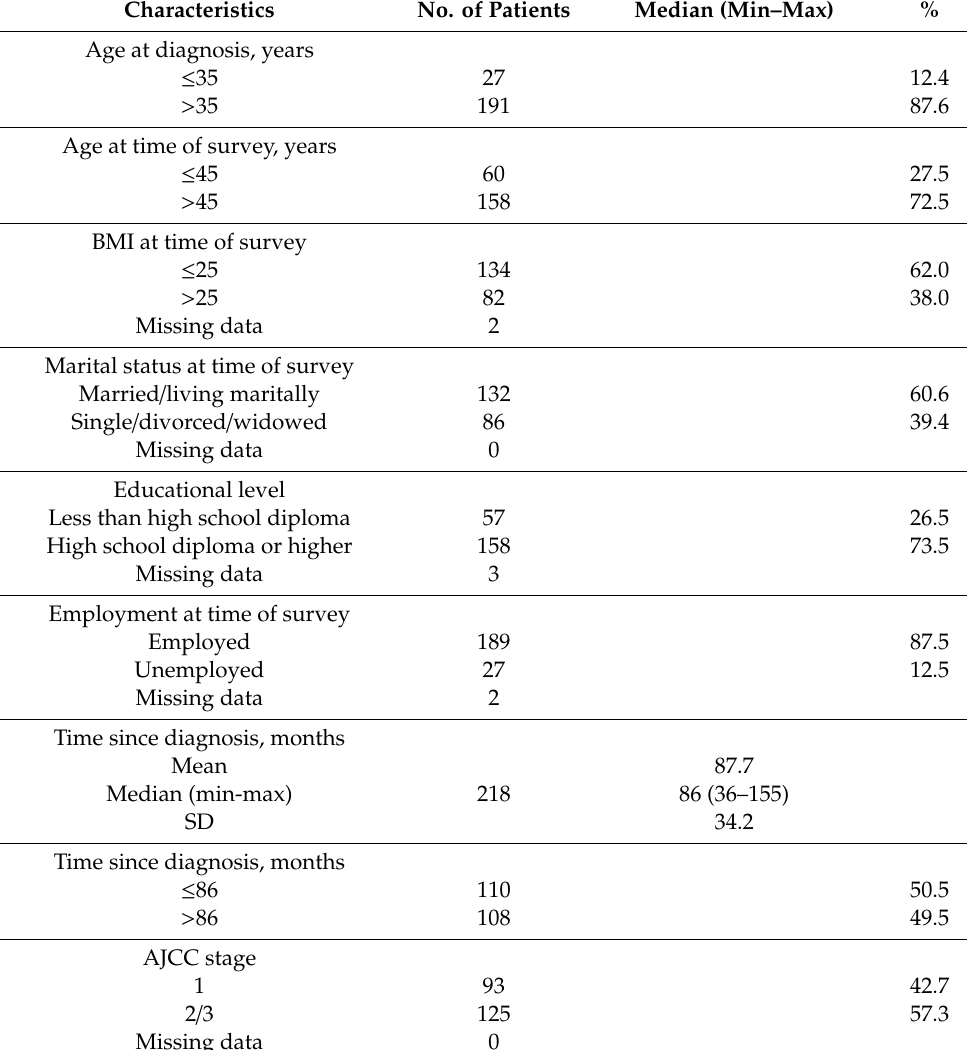
Table 1. Demographic and clinical characteristics of the study population (N =